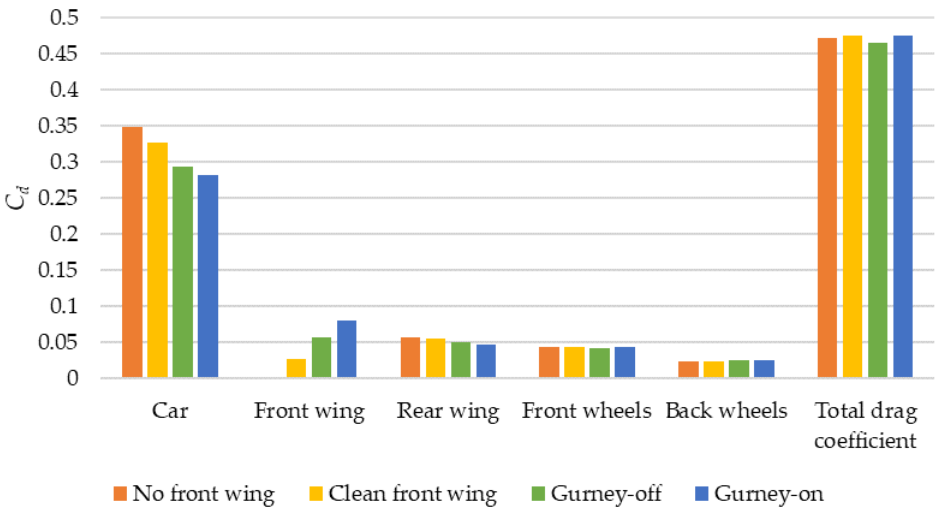
Figure 13. Drag coefficient distribution for cases without a front wing and with a front wing. It can be seen that the wing with the Gurney flap increases drag but decreases body drag. The drag of the rear wing and wheels is almost unchanged. A car with the front wing and Gurney flap off generates less aerodynamic drag than a car without the wing. Figure 14 shows how the lift forces are distributed between the body, front wing, rear wing, front wheels, and rear wheels. Also shown are the total lift coefficient values for the car configurations with no front wing, with a clean front wing, and with the wing with the Gurney flap off and on.